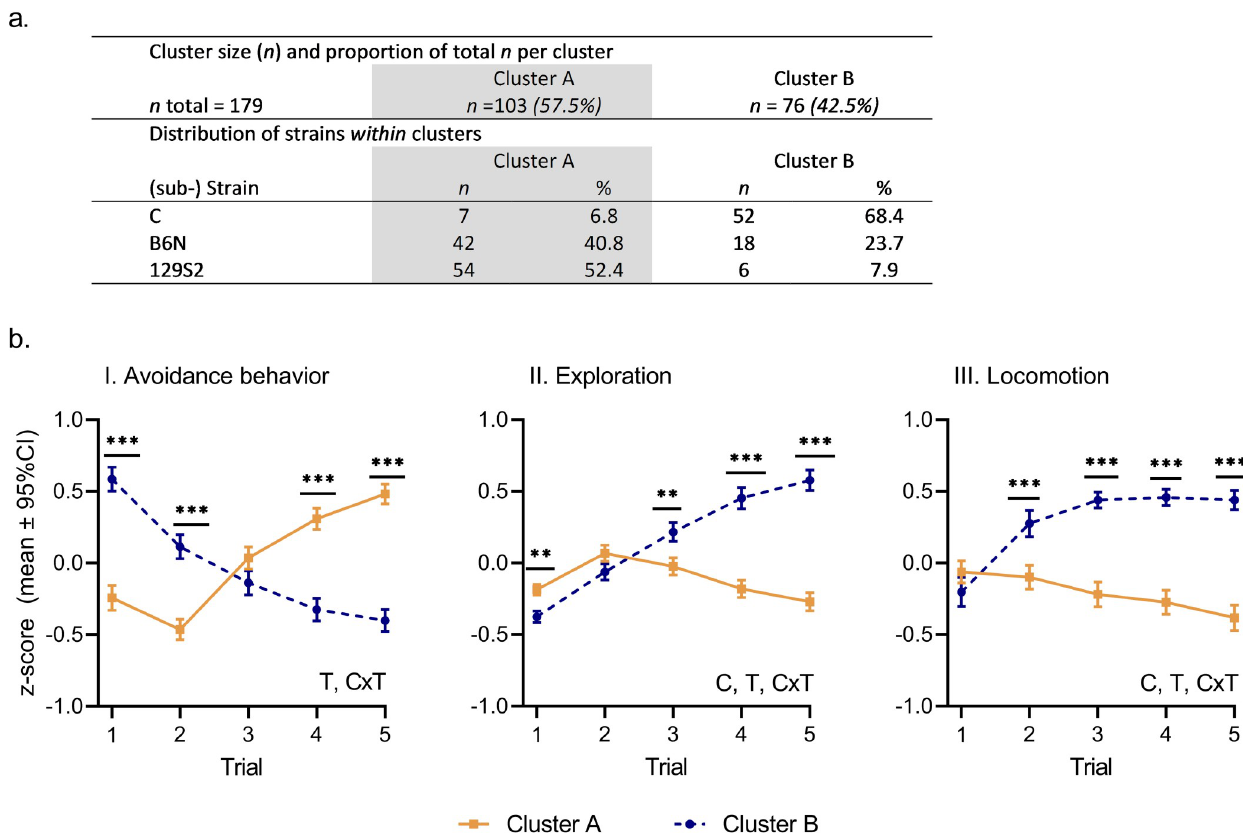
Fig 3. (a) Results cluster analysis. Top row: Cluster size and proportion of total population for each cluster (total number of mice, n = 179). Bottom rows: Distribution of strains ( n and proportion) within each cluster. (b) Behavioral response trajectories of clusters on avoidance behavior, exploration and locomotion (cluster A, orange; cluster B, blue). Behavior expressed as integrated behavioral z-scores. Results are presented as means with 95% CI. Effects were significant in LMMs at P < 0.05. C: Significant main effect of cluster; T: Significant main effect of trial; C x T: Significant interaction between cluster and trial. Significant differences in post hoc contrasts between clusters on trials 1 and 5 (adjusted α = 0.025321) are indicated by �� = 0.00050 � P < 0.00501, ��� = P < 0.00050. Significant differences in post hoc contrasts between clusters on trials 2, 3 and 4 ( α = 0.05) are indicated by �� = 0.001 � P < 0.01, ��� = P < 0.001. The raw scores (mean integrated behavioral z-score ± 95% CI) per trial, per cluster, for each behavioral dimension are listed in S3